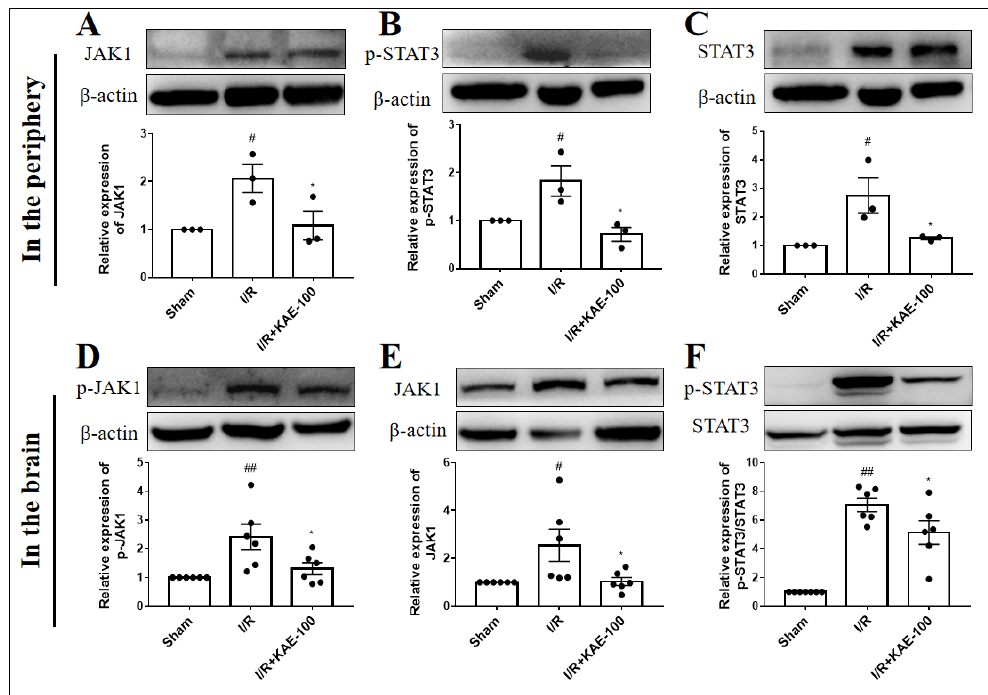
Figure 7. Effect of 100 mg/kg kaempferol on the expression of JAK1/STAT3 signaling pathway in peripheral blood neutrophils of rats on day 1 and in ischemic cortex of rats on day 3 after cerebal I/R. The expression level of ( A ) JAK1, ( B ) p-STAT3, ( C ) STAT3 in peripheral blood neutrophils ( n = 3) and ( D ) p-JAK1, ( E ) JAK1, ( F ) p-STAT3 in ischemic cortex was assessed by Western blotting analysis. Values are expressed as mean ± SEM. # p < 0.05, ## p < 0.01 vs. Sham group; * p < 0.05 vs. I/R